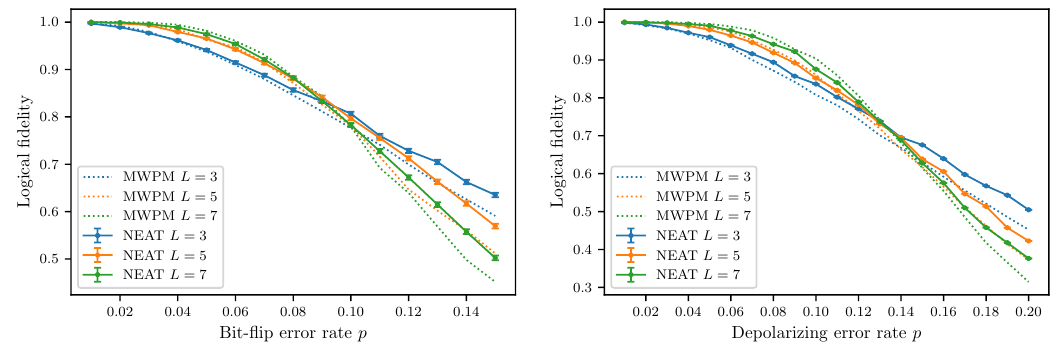
Figure 3: Logical error probability as a function of physical error rate p ent code distances d , for bitflip noise (left) and depolarizing noise (right). The results of MWPM are shown in dashed lines. The curves show the best performing policy network found by NEAT. Evaluation of the logical fidelity is done on 10 4 independent random games for each physical error